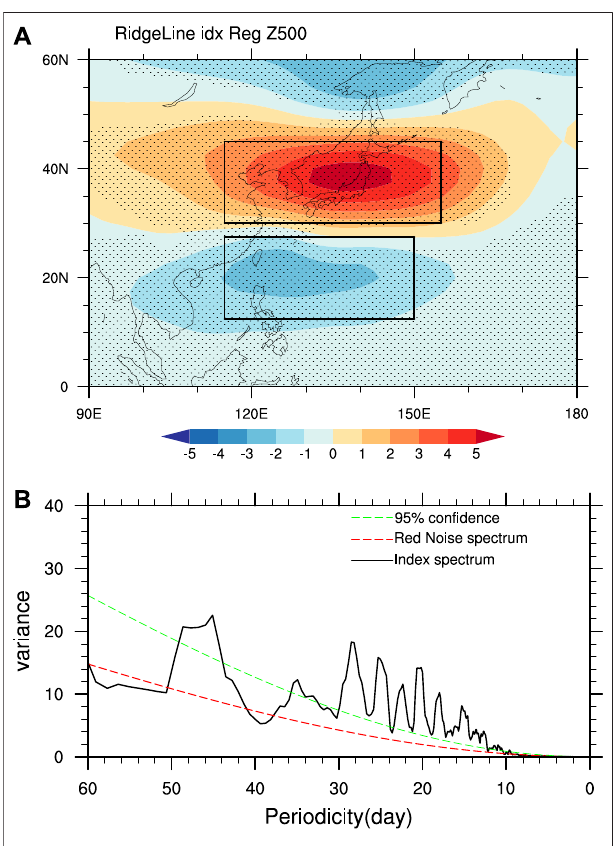
FIGURE 1 | (A) Regressions of 500 hPa geopotential height (unit: gpm) onto ridge line index of WPSH during July-August of 1980 – 2019 (The dots denote the areas statistically signi fi cant at the 0.05 level, and the black box indicates the key areas for the index of WPSH_SMI ). (B) Power spectra of the WPSH_SMI , with Markov red noise spectrum (red line) and spectrum signi fi cant at the 0.05 level (green